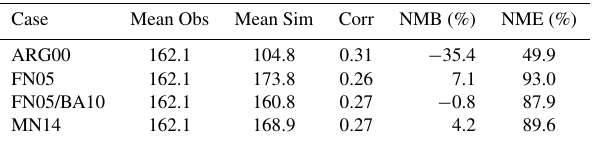
Table 9. Statistics for simulated CDNC for CB05-25%FF-EM3 against MODIS-derived CDNC from Bennartz (2007) for May to June 2010. All cases use the MSKF cumulus